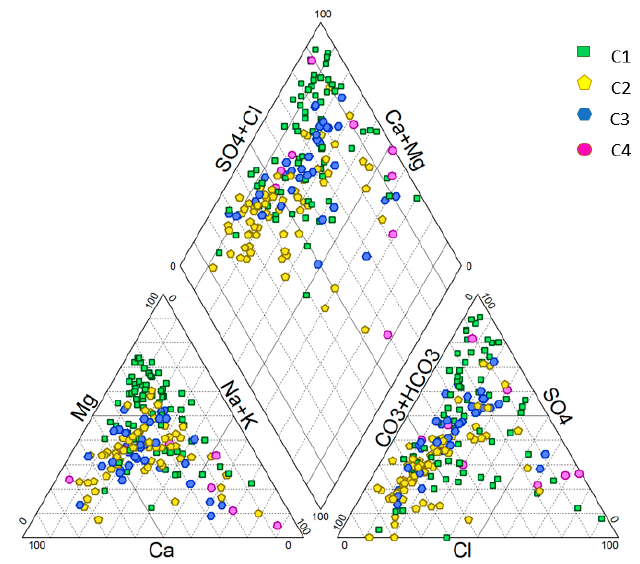
Figure 14. Plot of the samples on a Piper diagram.